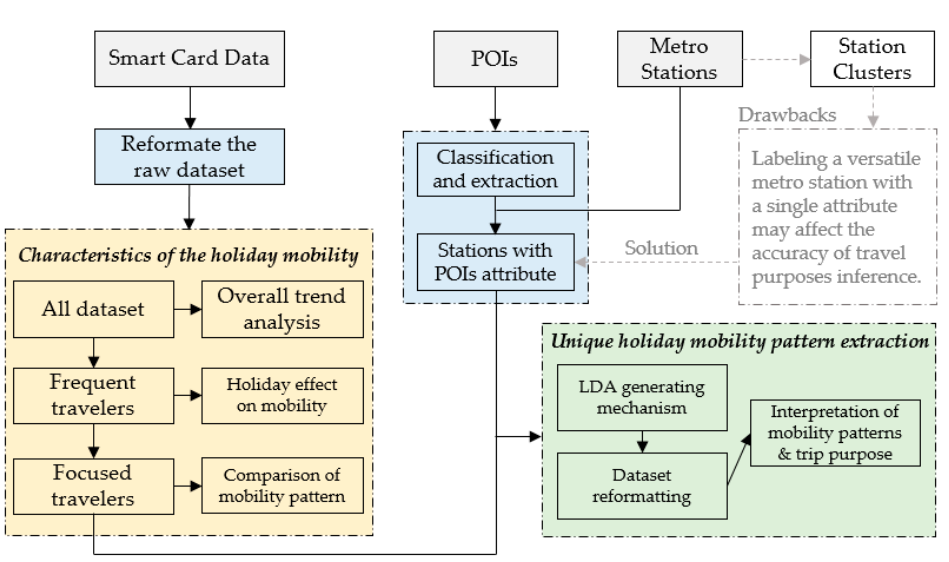
Figure 2. Research methodology framework of this paper.